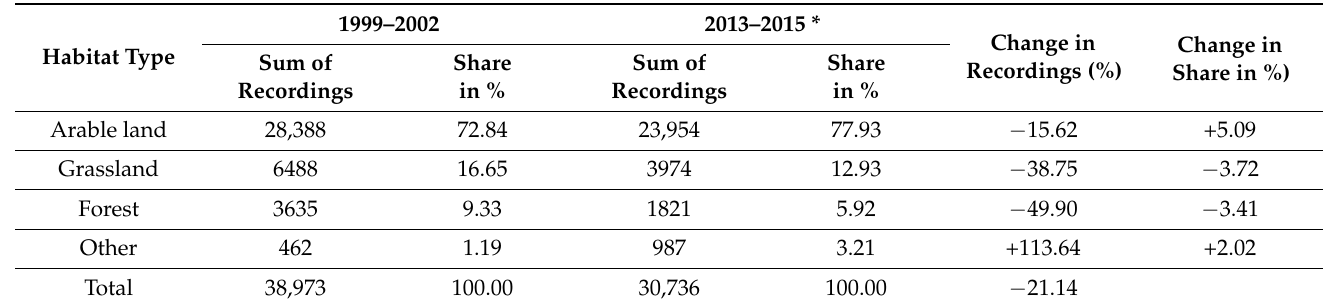
Table 4. Bird abundance at different habitat types and its share on abundance in the entire landscape ( γ